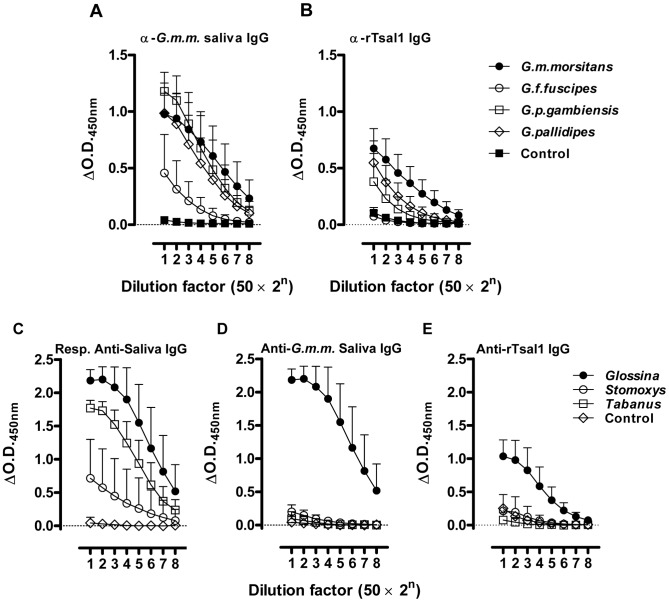
Detection of humoral responses induced by various hematophagous insects.Serially diluted plasmas of control mice and mice repeatedly exposed to the bites of G. morsitans morsitans, G. fuscipes fuscipes, G. palpalis gambiensis and G. pallidipes (n = 5/group) were tested in the G. m. morsitans saliva-based (A) and rTsal1-based IgG detection ELISA (B). Serially diluted plasmas of control mice and mice experimentally immunized with harvested G. m. morsitans, Stomoxys calcitrans and Tabanus yao saliva (n = 6/group) were analysed for responses against the respective saliva extracts (C) and were tested in the G. m. morsitans saliva-based (D) and rTsal1-based IgG detection ELISA (E). Presented data are the mean ΔO.D.450 nm values with the 95% CI.